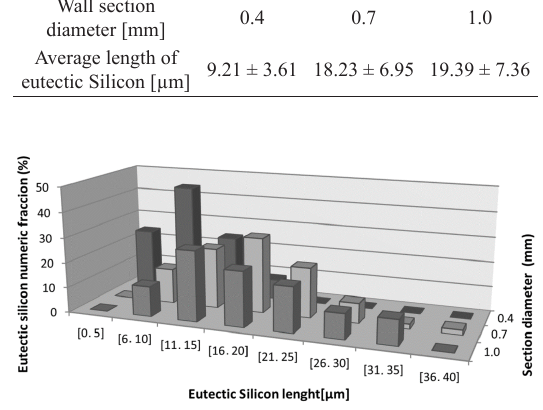
Figure 12. Microstructures of samples poured at 635 °C in a mold at 350 °C for different wall section diameters: (a) 0.4 mm, (b) 0.7 mm and (c) 1mm - [Zone 2].